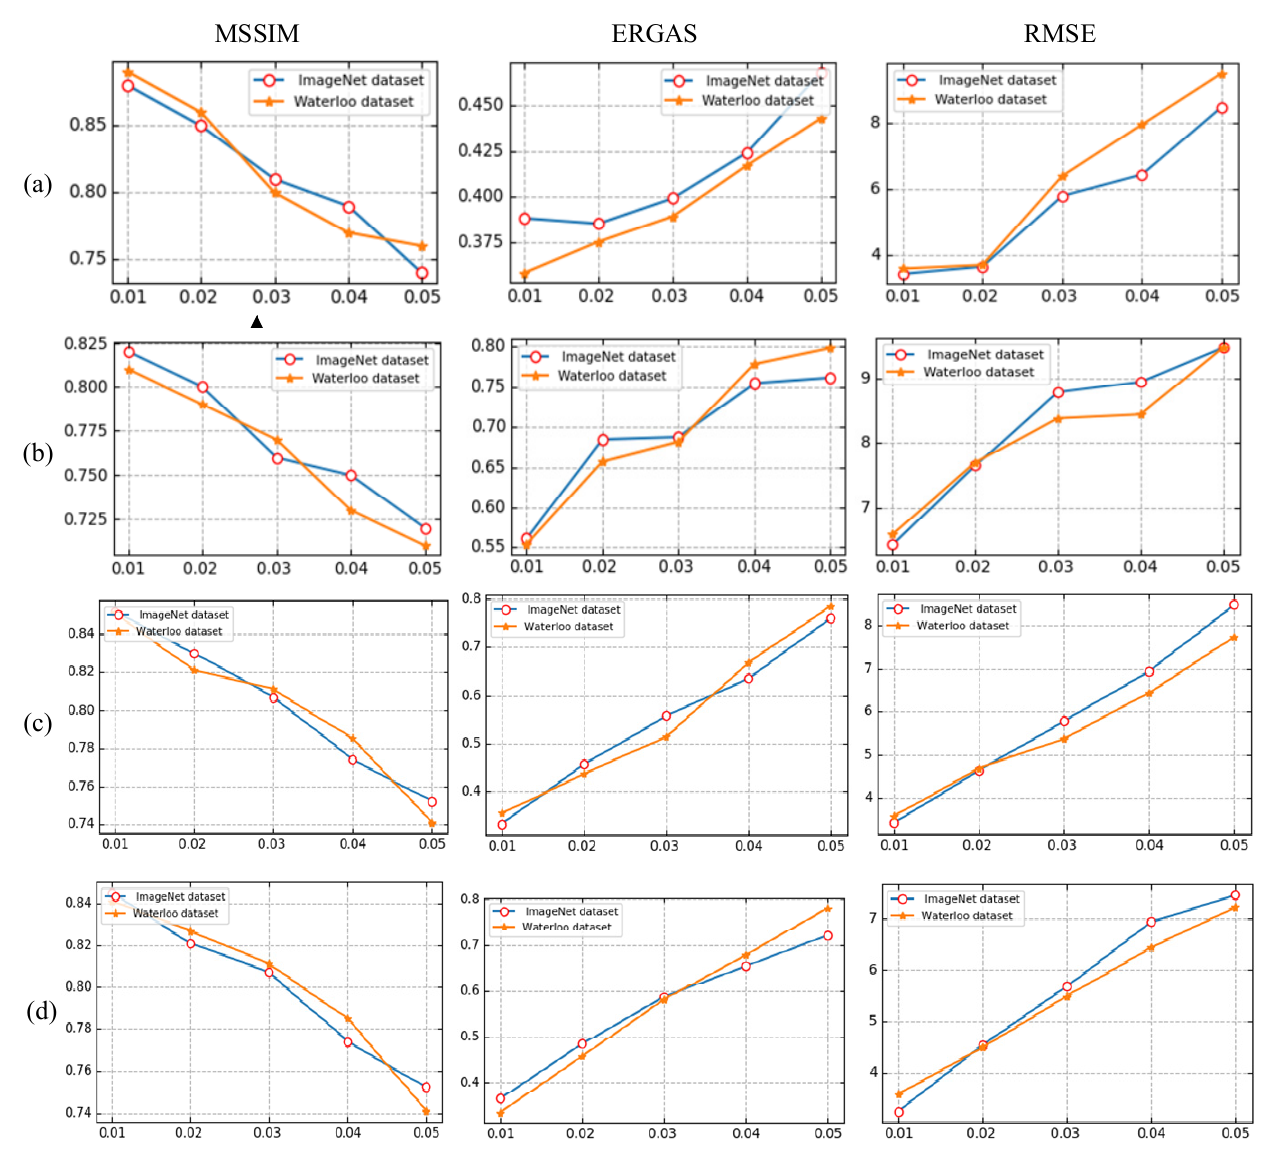
Figure 14. Comparison of the results of the RMSE, ERGAS, and MSSIM relative to the noise levels for different algorithms: ( a ) proposed algorithm, ( b ) Ref [32], ( c ) Ref [1], and ( d ) Ref [3]. Table 7. Time consumption compared with other methods.